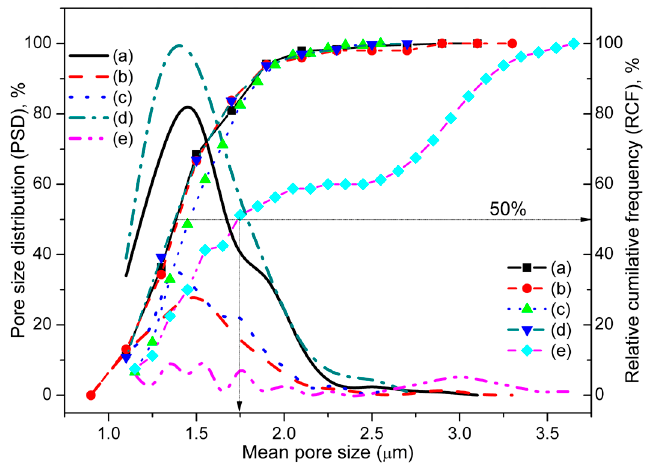
Figure 3. Pore size distribution (PSD) and relative cumulative frequency (RCF) of ( a ) unsintered and sintered at ( b ) 450 °C, ( c ) 650 °C, ( d ) 850 °C and ( e ) 1050 °C materials measuring from the electron sintered at ( b ) 450 ˝ C, ( c ) 650 ˝ C, ( d ) 850 ˝ C and ( e ) 1050 ˝ C materials measuring from the electron micrographs using ImageJ. micrographs using